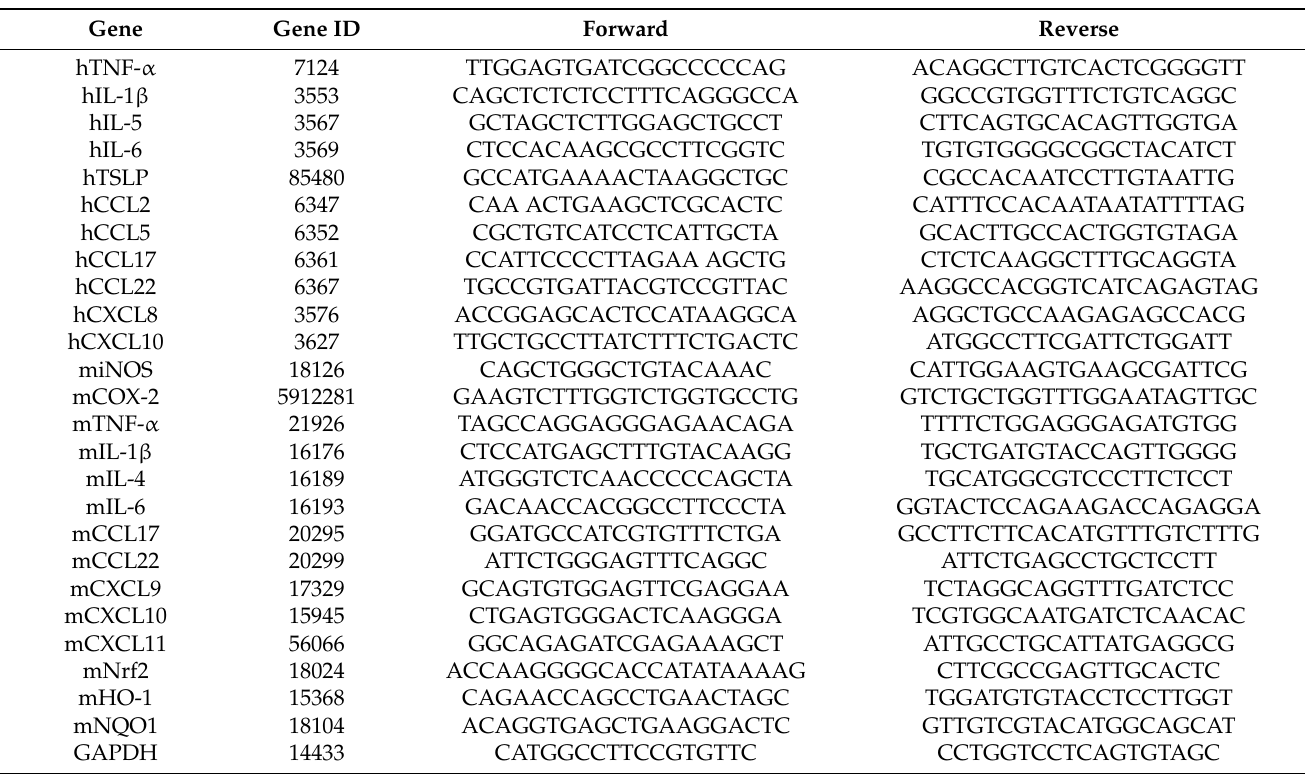
Table 1. Primer sequences for real-time